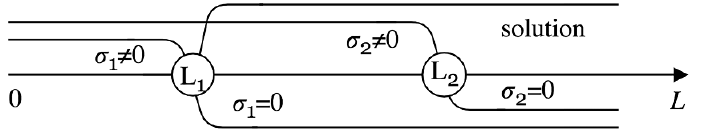
Figure 2 . Schematic depiction of the phase structure. The system (4.1){(4.3) has the solution only for L > L 1